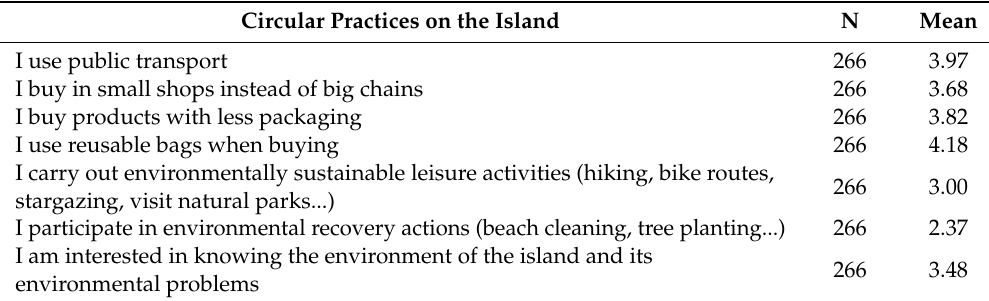
Table 13. Circular practices carried out by tourists on the